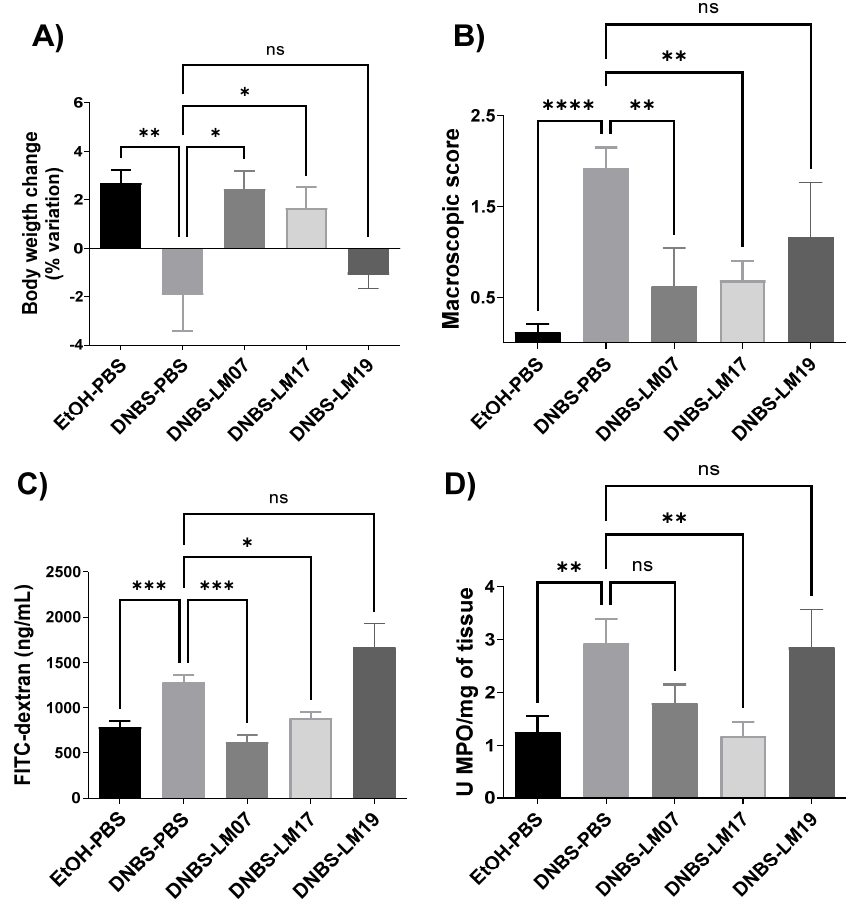
Figure 5. Effect of Lactobacillus strains isolated from agave samples in a DNBS chronic colitis model. ( A ) Body weight variation of mice, ( B ) macroscopic score, ( C ) gut permeability, and ( D ) MPO/mg of tissue . Results are presented as the means ± SEM. ns: not significant, * Indicates a significant difference as compared to the DNBS group ( p < 0.05, **p < 0.01, *** p < 0.001, **** p< 0.0001).